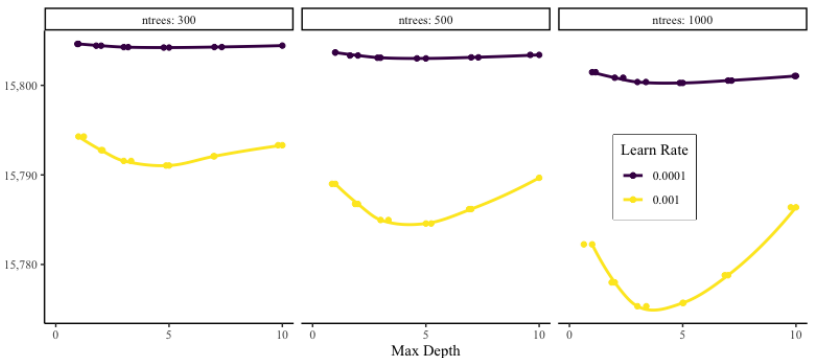
Figure 6. Visualization of the results from tuning gradient boosted forests to predict severity on the BI data (note that only models with the distribution tuning parameter set to “Laplace” are shown since their MAE was much less than the other models). Validation MAE is shown on the y -axis as it changes according to the maximum depth of each tree in the gradient boosted forest. Each pane shows a different number of trees in the forest while each colored line represents a different learning rate.